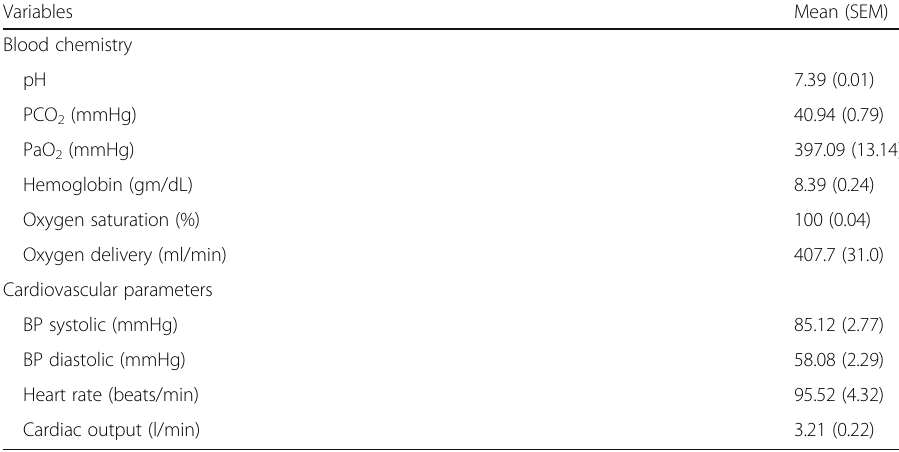
Table 1 Baseline physiologic characteristics